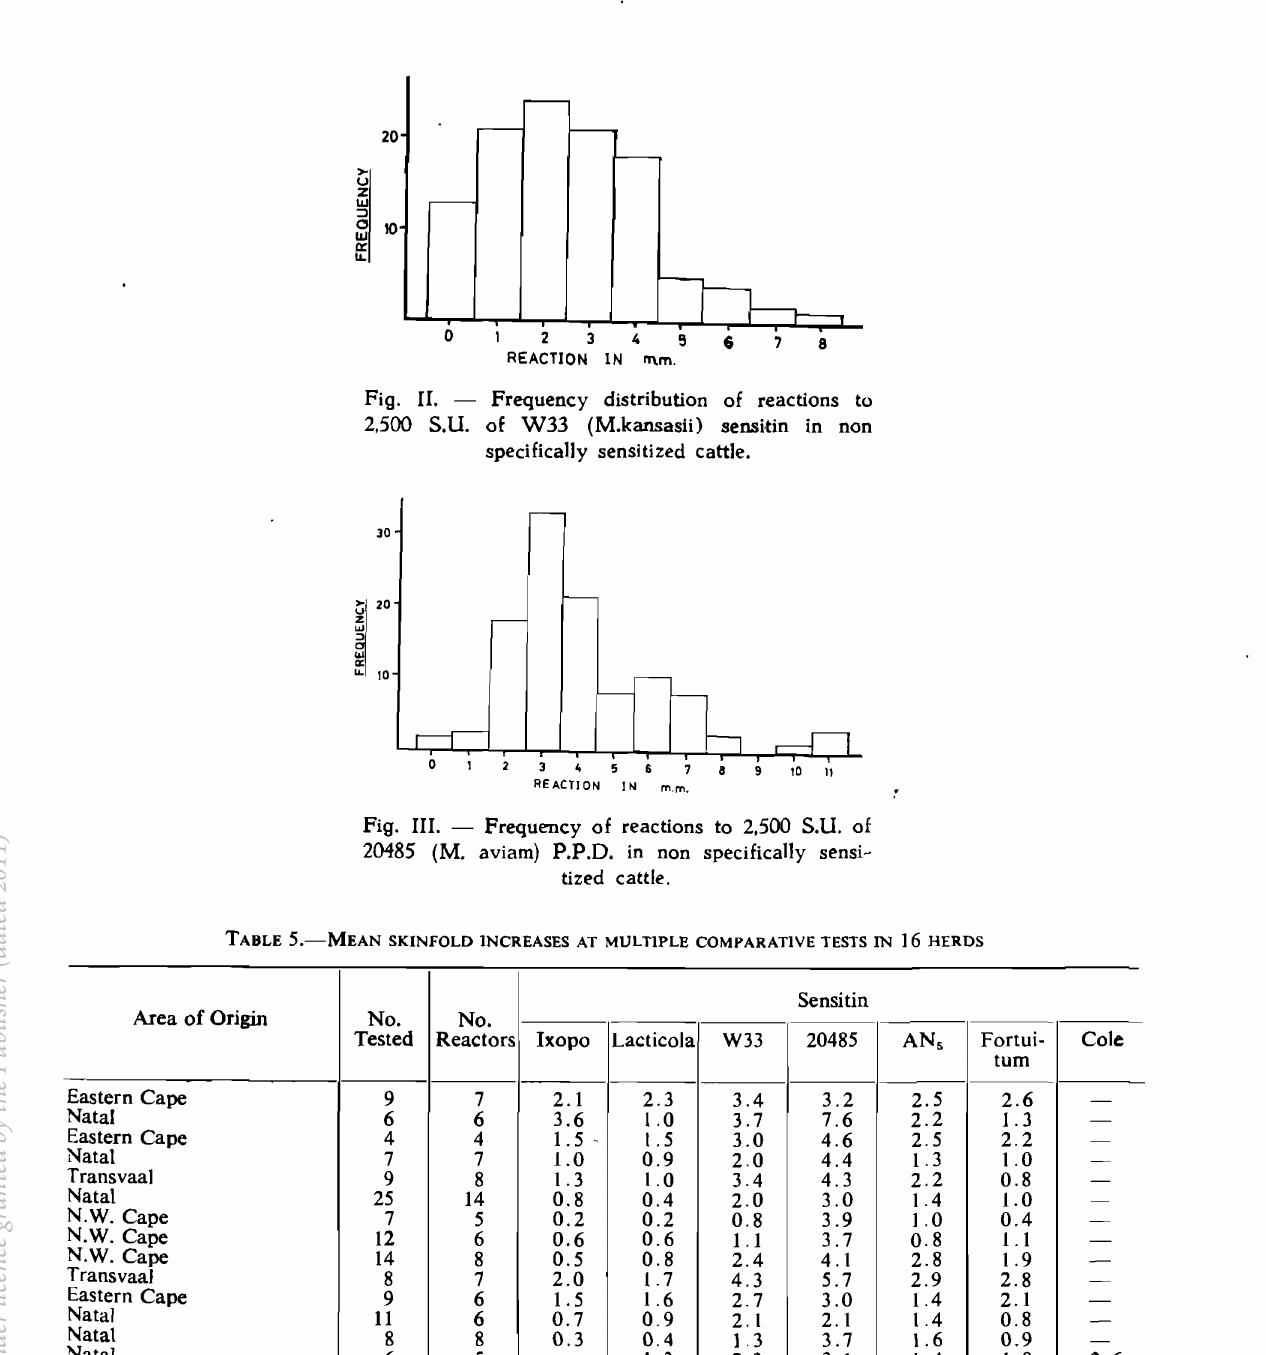
Fig. II. - Frequency distribution of reactions to 2.500 S.U. of W33 (M.kansasH) sensi,tin in non specifically sensitized cattle.